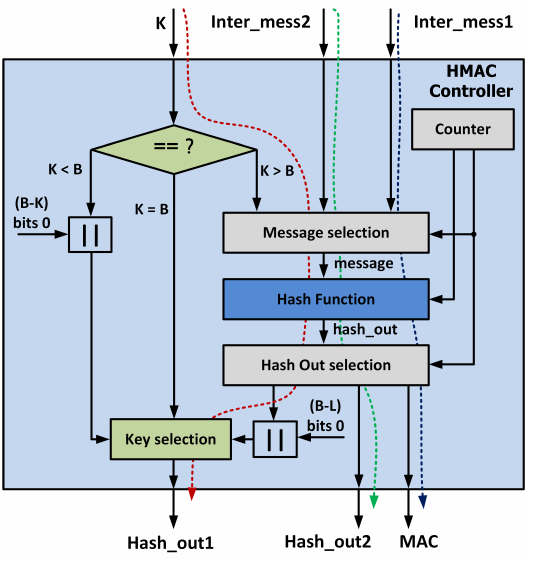
Figure 9. Proposed hardware architecture of HMAC